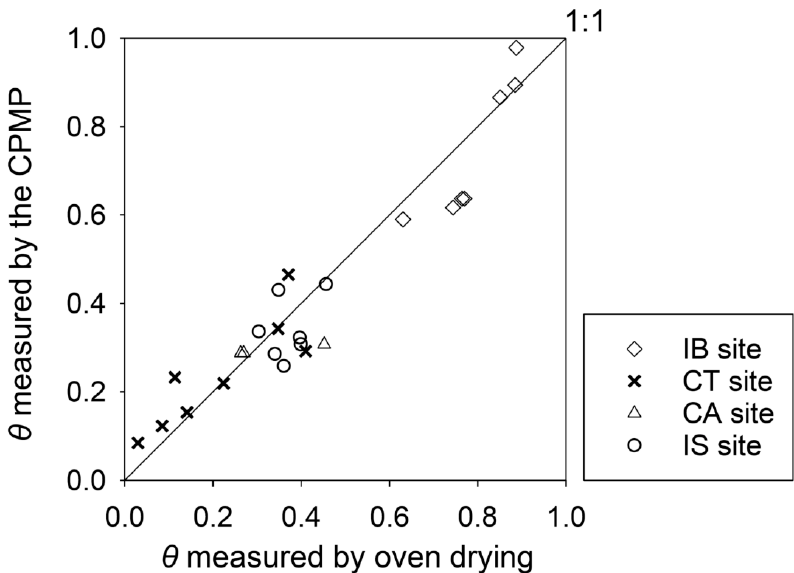
Figure 3. Relationship between θ measured by oven-drying a 100-cm 3 soil core sample and θ measured by the CPMP for soils at different study sites.